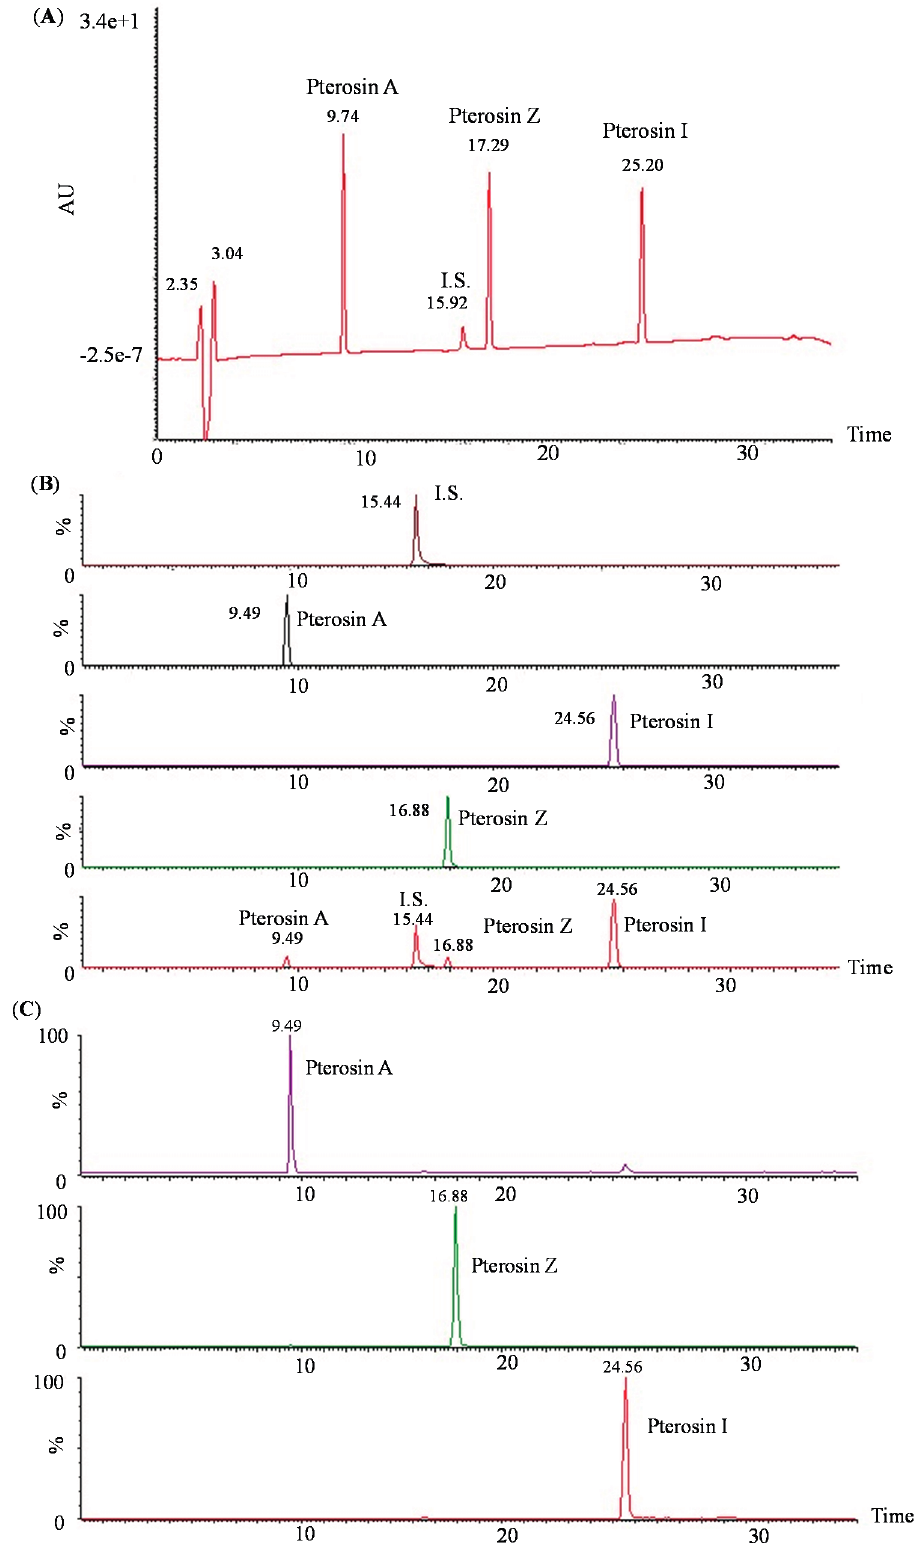
Figure 3. LC–MS–MS chromatography of pterosins. ( A ) High-performance liquid chromatography of pterosins A, I, and Z and piromidic acid (internal standard); ( B ) Multiple reaction monitoring chromatography corresponding to the LC–MS–MS analyses of pterosins and piromidic acid and ( C ) daughter ion